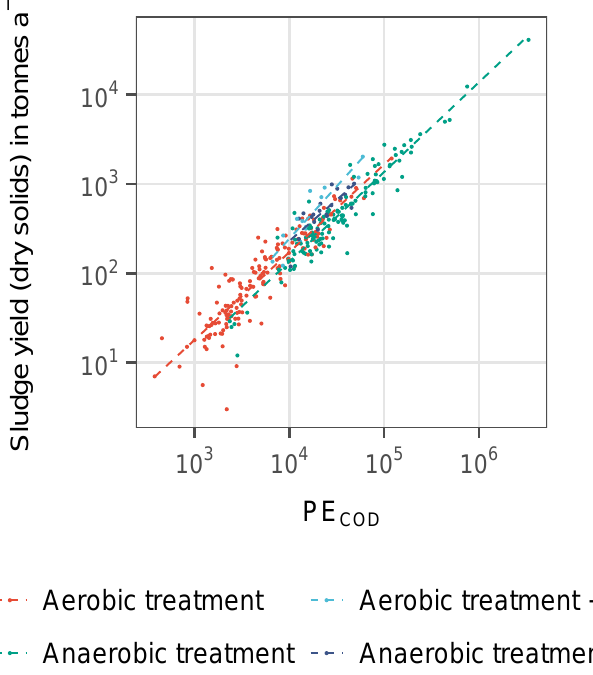
Figure 2. Total sludge yield (as dry matter) in tons per year as a function of treated population equivalents (PE; derived from COD with 120 g COD PE − 1 d − 1 ) and dependent on the primary sludge stabilization method as well as on potential lime addition. Statistical values are provided in Table